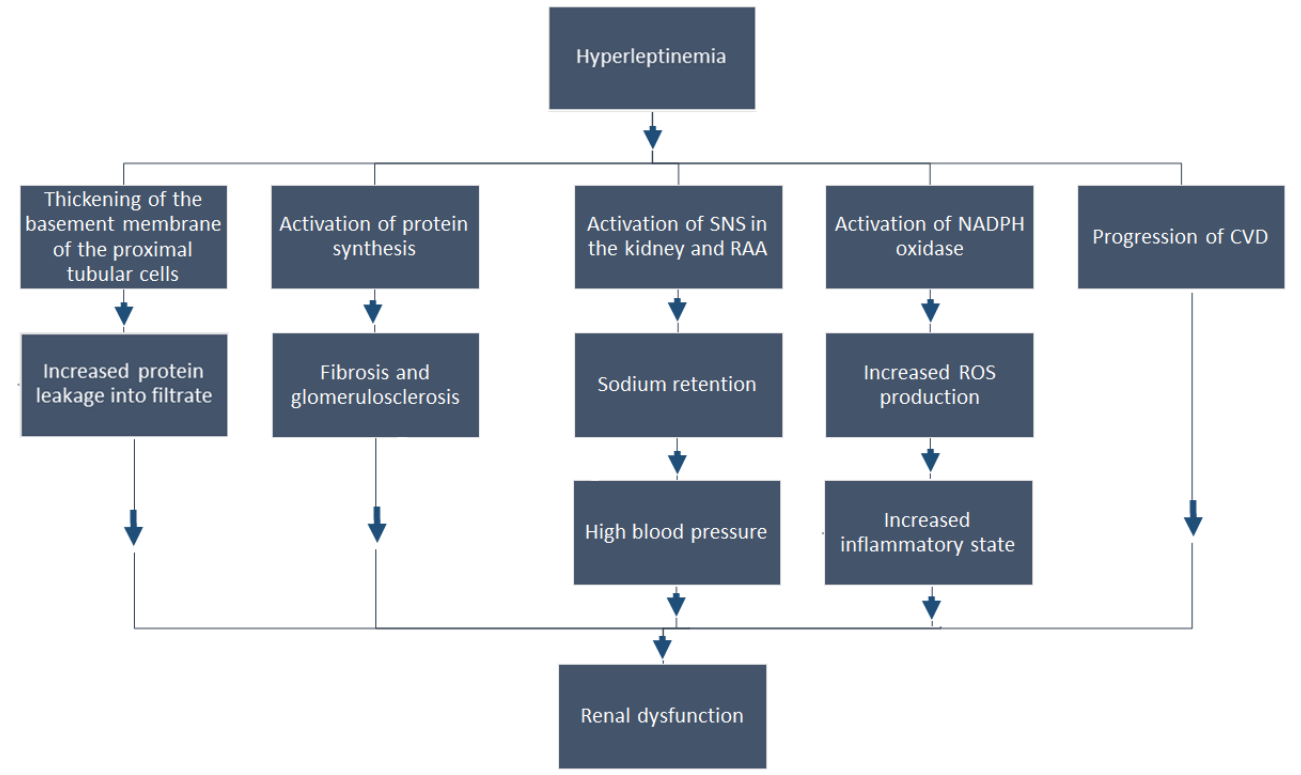
Figure 2. The potential mechanisms of the harmful effect of hyperleptinemia on kidney function in CKD patients. CVD— cardiovascular disease, ECM—extracellular matrix, RAA—renin–angiotensin–aldosterone system, ROS—reactive oxygen species, SNS—sympathetic nervous system.